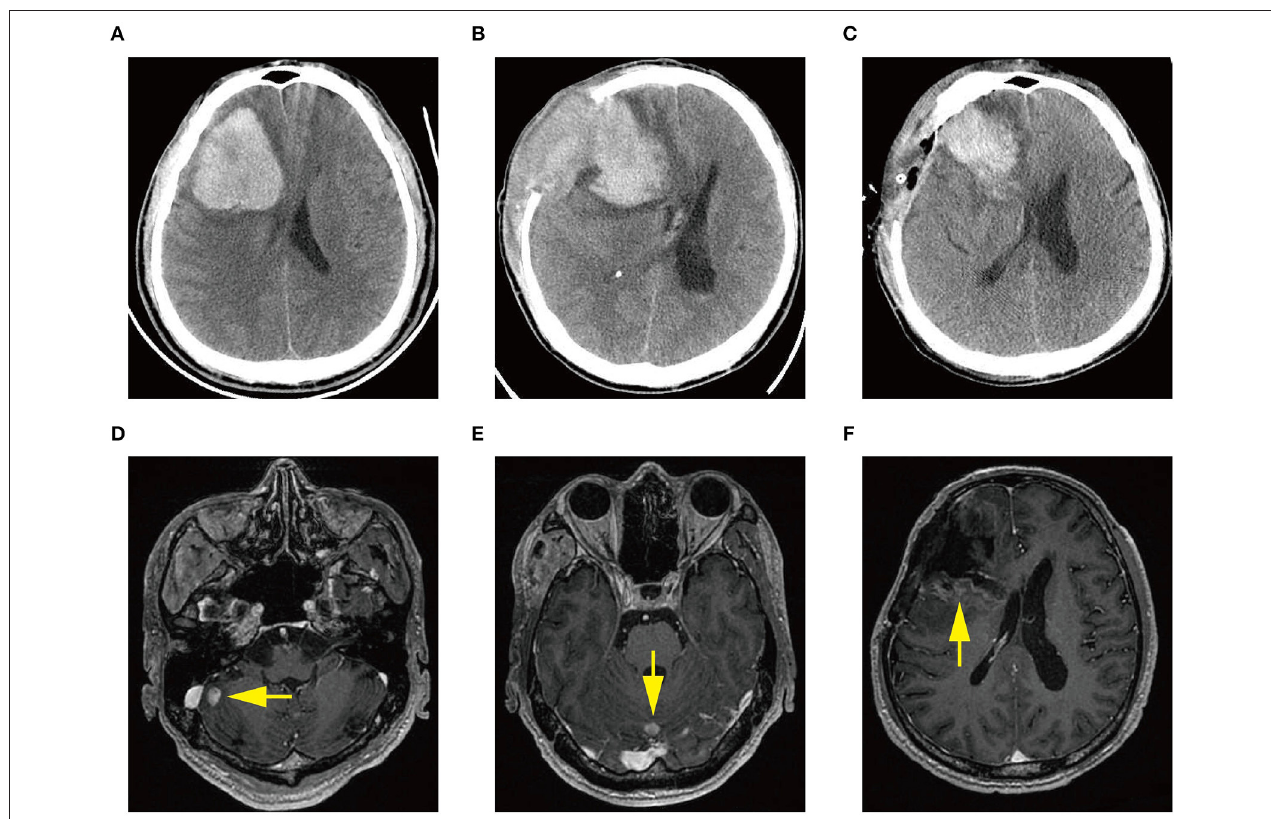
FIGURE 1 | (A) Computed tomography (CT) scan at diagnosis demonstrating acute intracerebral hemorrhage (ICH) in the right frontal lobe. (B) CT scan demonstrating ICH re-occurrence at day 3 after the first craniotomy. (C) CT scan demonstrating rebleeding after the second craniotomy. (D–F) Magnetic resonance images showing multiple intracranial lesions (arrow) 1 month after the first